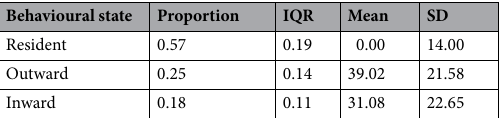
Table 1. The proportion of time spent in each behavioural state, associated interquartile range (IQR) and state dependent distribution parameters (mean and standard deviation (SD)) estimated by the hidden Markov model based on all estimated tracks from tagged juvenile southern bluefin